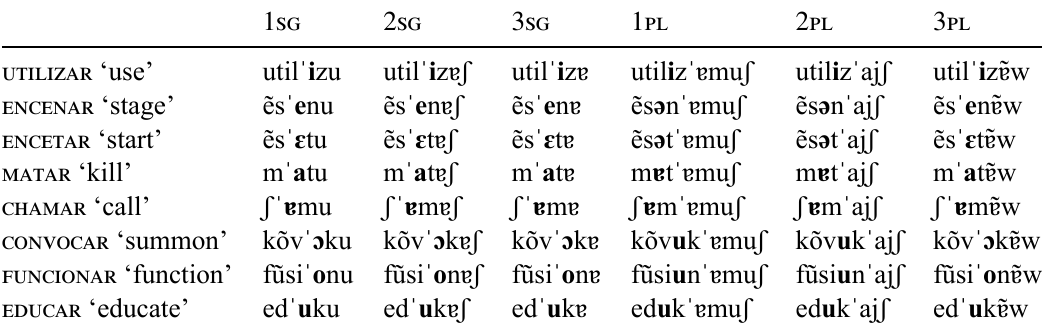
Table 20: Examples of the effects of vowel reduction on the present